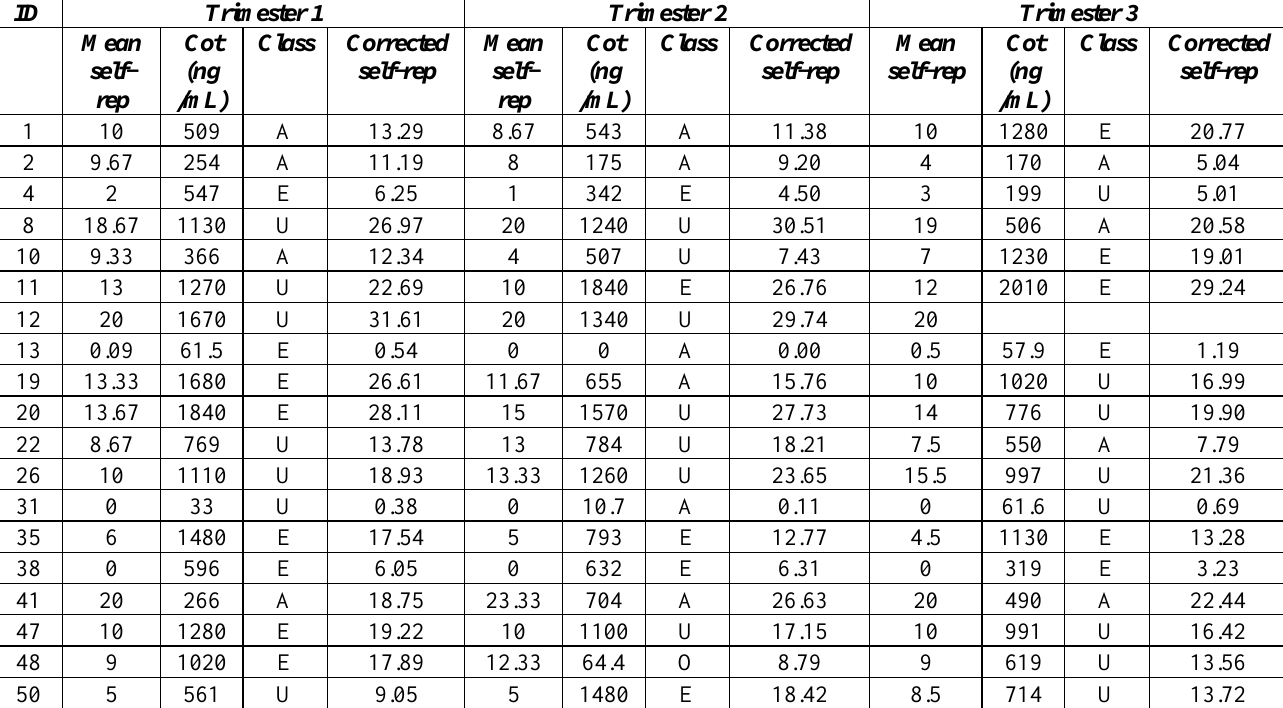
Table 2. Classification of women based on the individual MC corrections, under scenario 3. For each trimester, the first column (“Mean self-report”) shows the self-reported trimester daily average number of cigarettes. The second column (“Cot”) shows the cotinine level from the urine test in the given trimester. The third column (“Class”) shows the classification of the woman: O for over-reporter, A for accurate reporter, U for under- reporter, and E for extreme under-reporter. The fourth column (“Corrected self-rep”) shows the corrected average trimester self-report. No adjustment could be calculated for women with missing cotinine